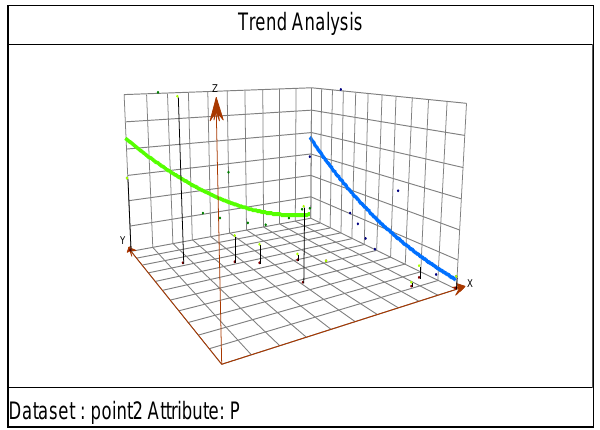
Figure 3. Identifying global trends in the present work data